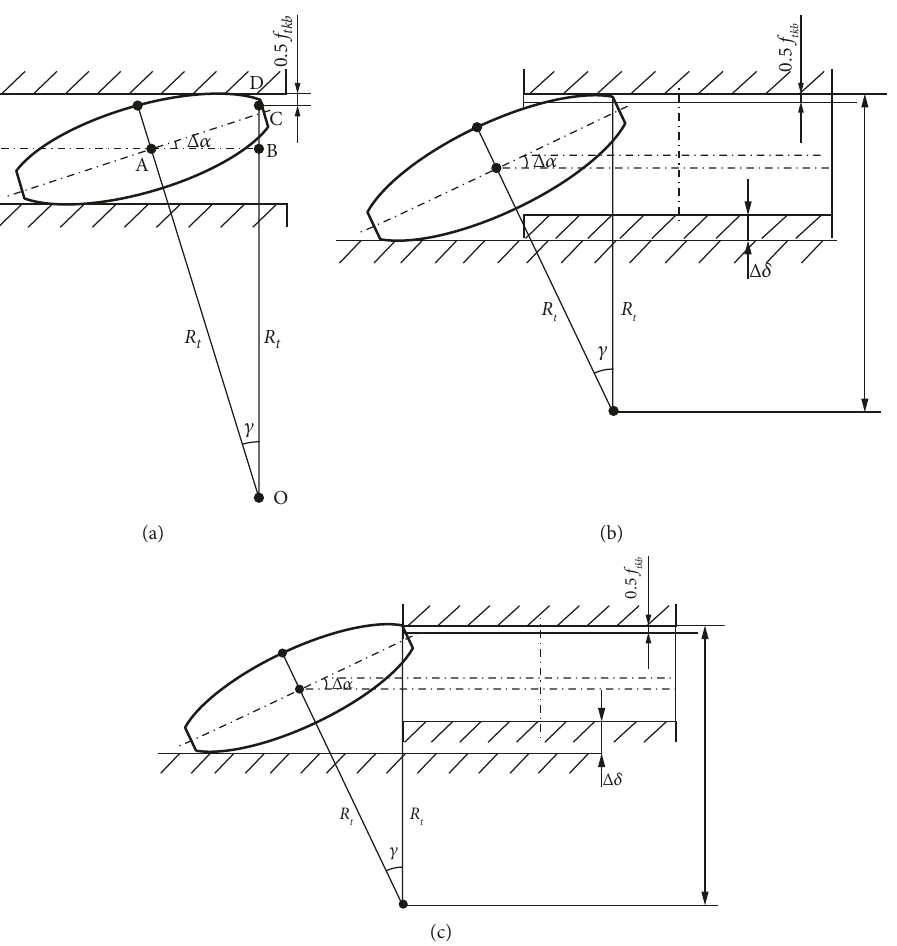
Figure 6: Schematic diagram of the relationship between the axis angle between the drum tooth disk and the output flange c and the angular displacement Δ α . (a) The internal teeth of the drum tooth disk are completely in the external teeth of the output flange. (b) The internal teeth of the drum tooth disk are partially out of the external teeth of the output flange. (c) The internal teeth of the drum tooth disk are about to completely escape from the external teeth of the output